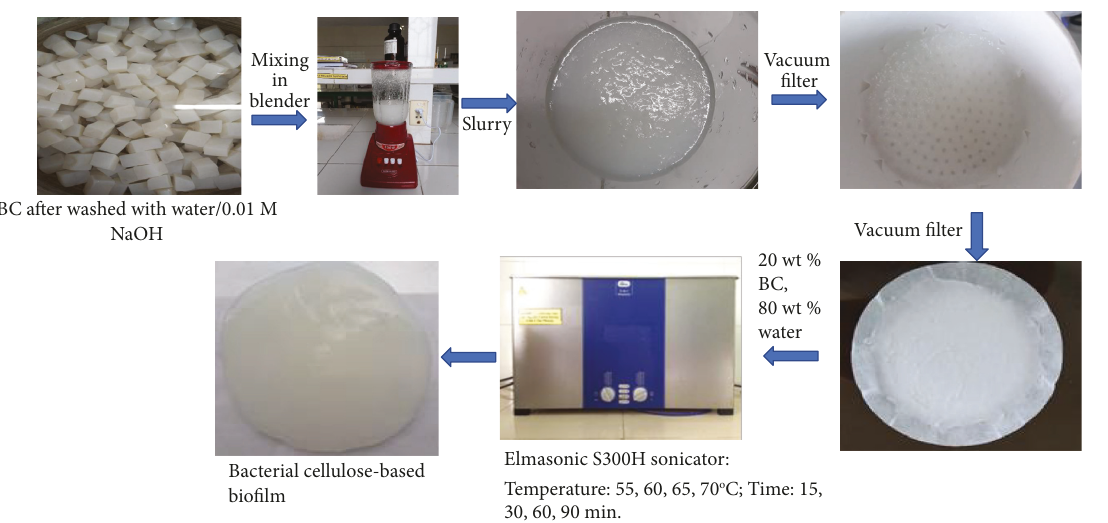
Figure 1: Procedure for isolating BC from nata de coco by the sonication